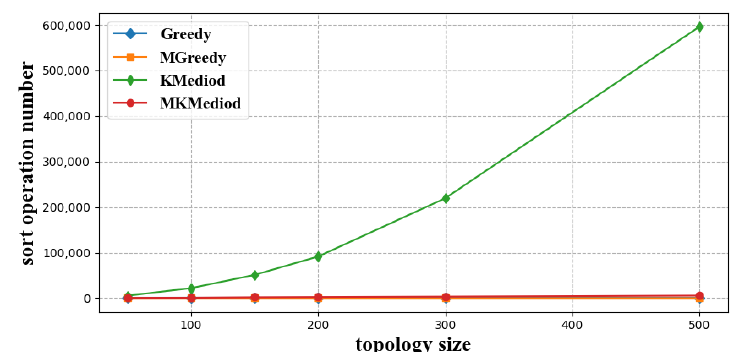
Figure 5. Number of sort operations of each algorithm with different network sizes.